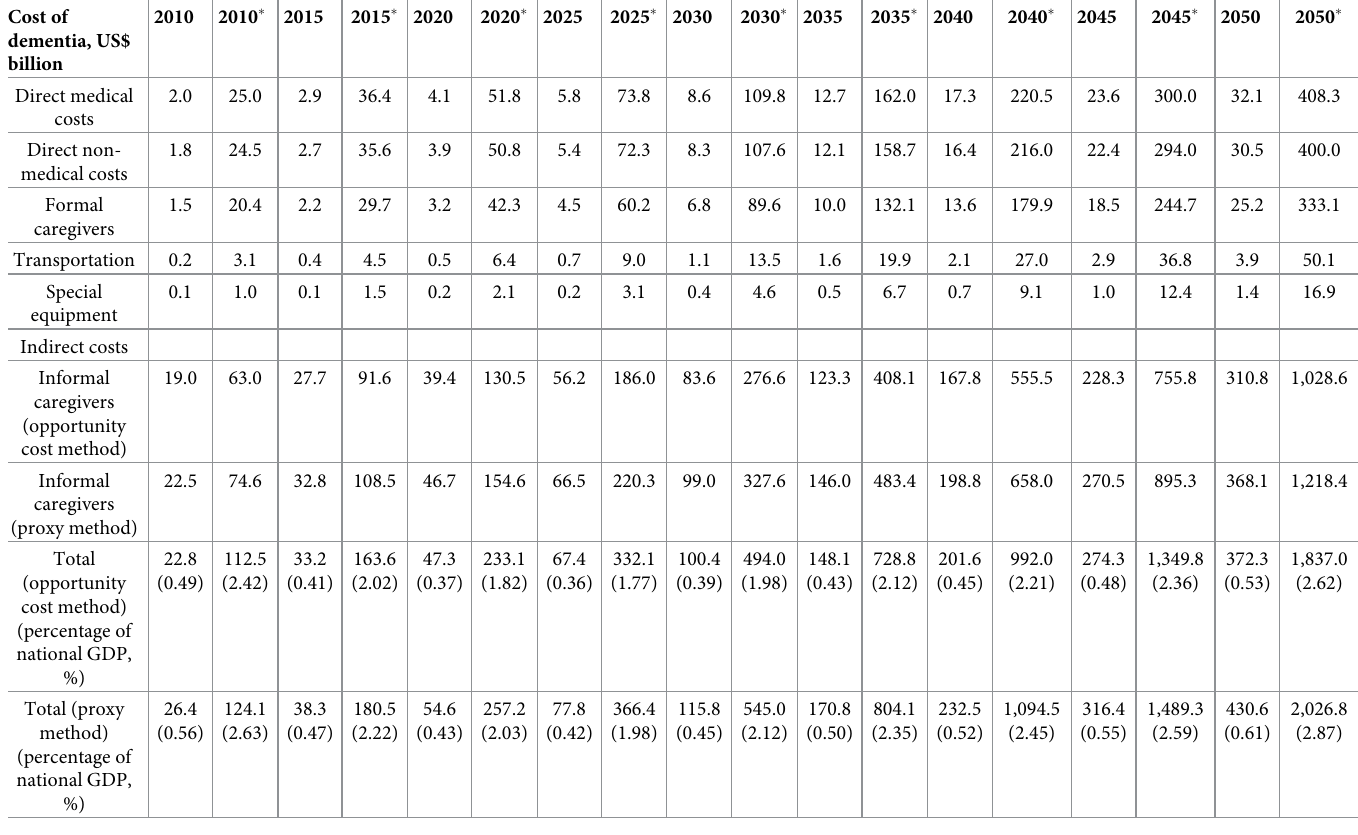
Table 4. Annual cost of care for individuals with dementia in China from 2010 to 2050, differentiated by methods measuring indirect costs. Cost of dementia,